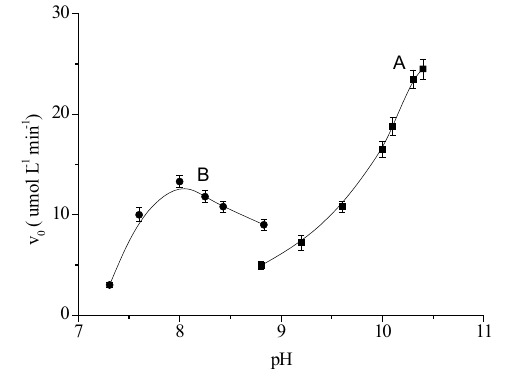
Figure 2. Effect of pH on the catalytic activity of YADH in the GGDE/ TX-100 mixed reverse micelle ( ω = 28, A) and AOT 0 reverse micelle ( ω = 30, B). 0